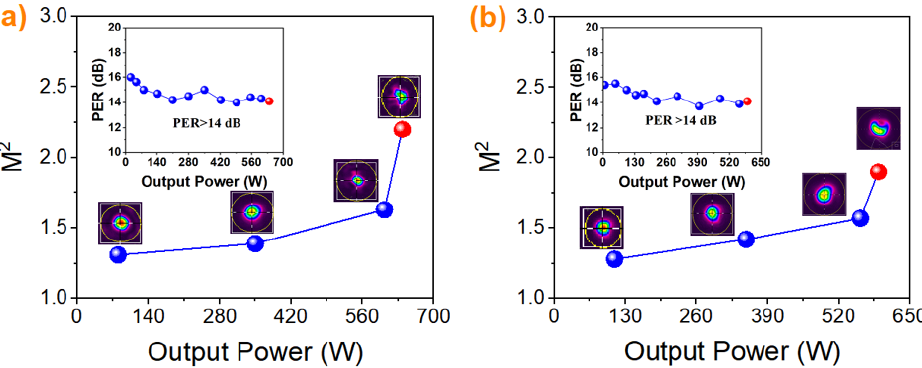
Figure 6. Measured beam quality and beam profile at different output powers. Inset: measured PER at different output power. ( a ) SFFA under single wavelength pumping. ( b ) SFFA under the hybrid pumping with a power ratio of